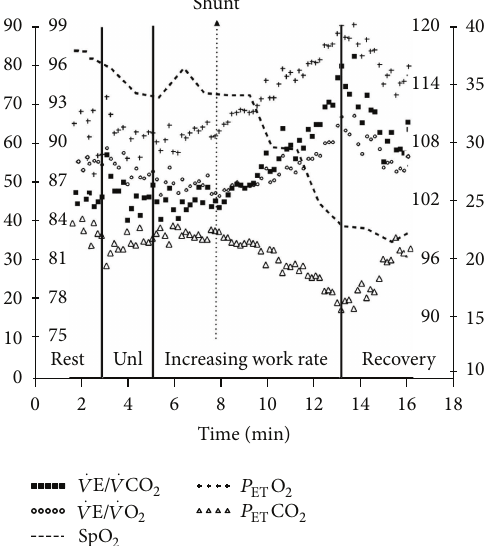
Figure 8: Exercise-induced right-to-left shunt as suggested by sudden decrease in oxyhemoglobin saturation by pulse oximetry (SpO 2 ) and abrupt increases in the ventilatory equivalents for ̇𝑉 ̇𝑉 / ̇𝑉 / ̇𝑉 and ) associated with a sustained CO 2 and O 2 ( E CO 2 E O 2 CO 2 ) with a decrease in the end-tidal partial pressure for CO 2 (𝑃 ET O 2 in a patient with pulmonary arterial concomitant increase in 𝑃 ET hypertension. Shunting of systemic venous blood in the arterial cir- culation stimulated the peripheral chemoreceptors thereby leading to this pattern of ventilatory and gas exchange responses. Unl is unloaded